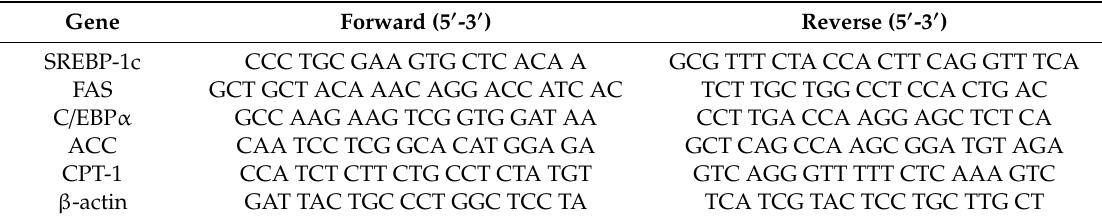
Table 1. Primer sequences used for